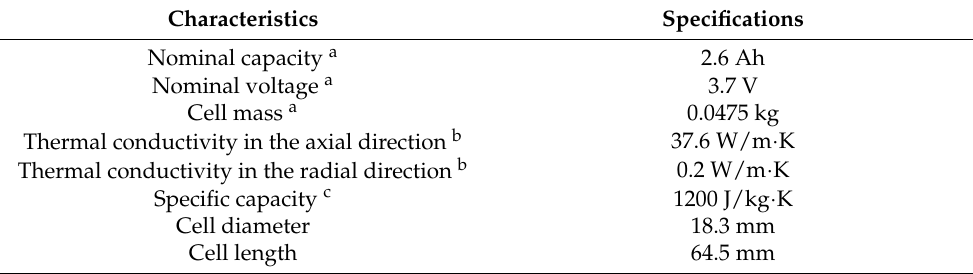
Table 1. The specification of the lithium-ion battery investigated in this